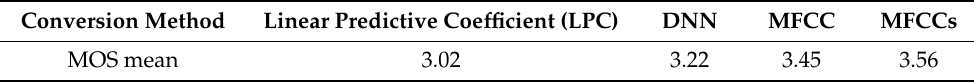
Table 1. Comparison of the MOS scores for four methods.